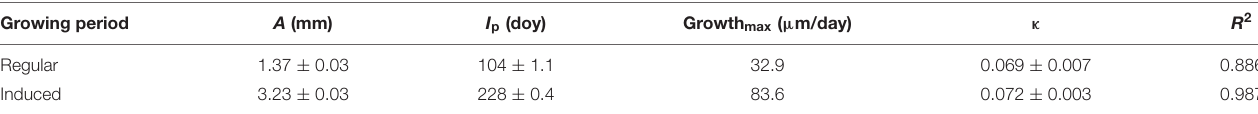
Mean values ± standard deviations are shown.